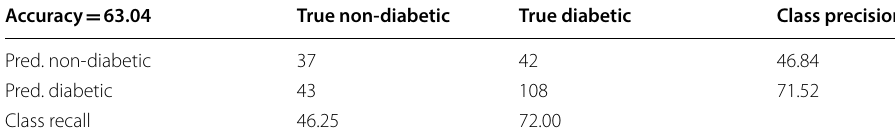
Table 7 Results of KNN